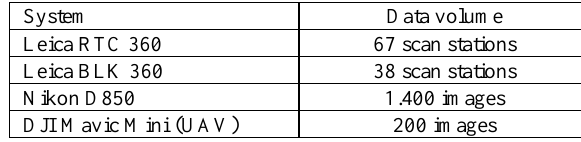
Table 3: Measurement systems and data volume for reconstruction.